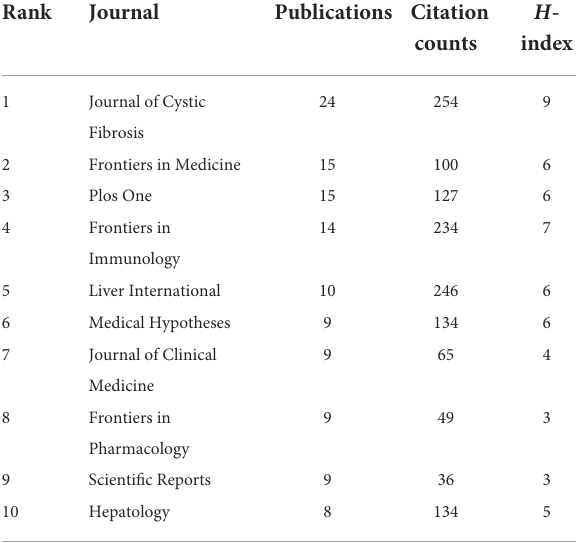
TABLE 6 The ranking of top 10 journals that published most papers on post-COVID-19